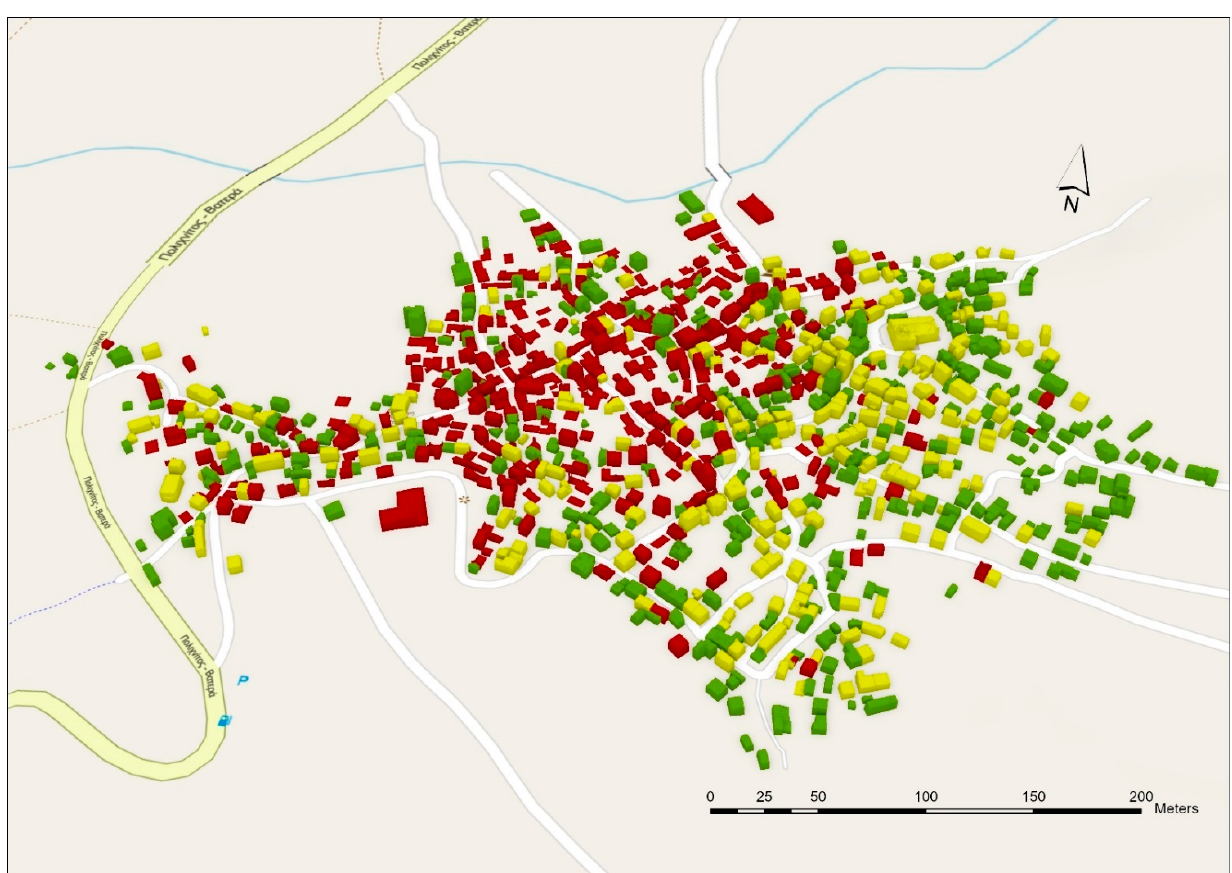
Figure 1. The study area of the Vrisa settlement with LOD2 buildings based on the categorization of EPPO in 3 classes: i. red—dangerous for use; ii. yellow—unsafe for use; iii. green—safe for use. Up until today, the majority (>90%) of “red buildings” have been demolished while more than 80% of the “yellow buildings” have been repaired.